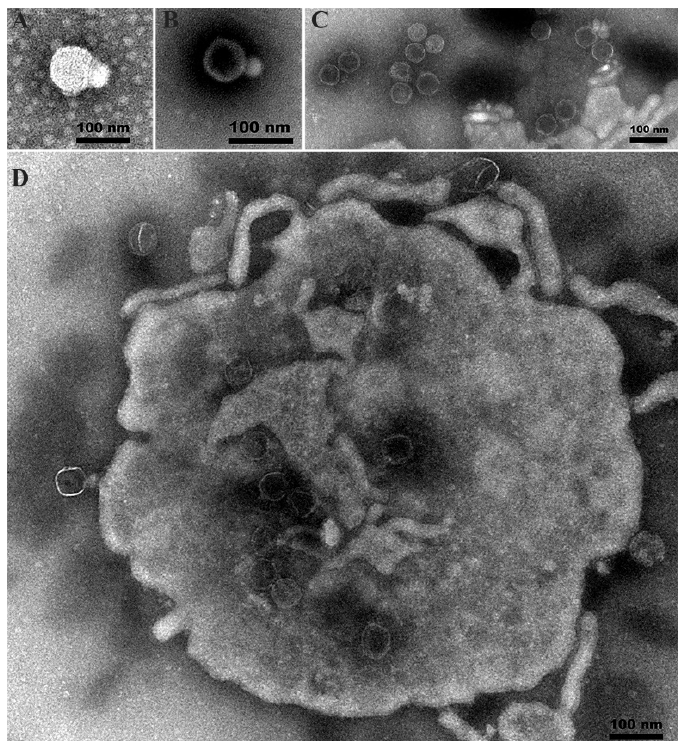
Figure 2. Transmission electron microscopy of negatively stained Aeromonas phage Ahy-yong1 and A. hydrophila A18 cell infected with Ahy-yong1. ( A – C ) Free intact-matureAhy-yong1 virion. Ahy- yong1 possesses a head with a diameter of 66 nm and a short non-contractile tail of 26 nm in length and 32 nm in width under a transmission electron microscope. ( D ) Immature phage particles being packaged within a viral factory in an infected A. hydrophila A18 cell.